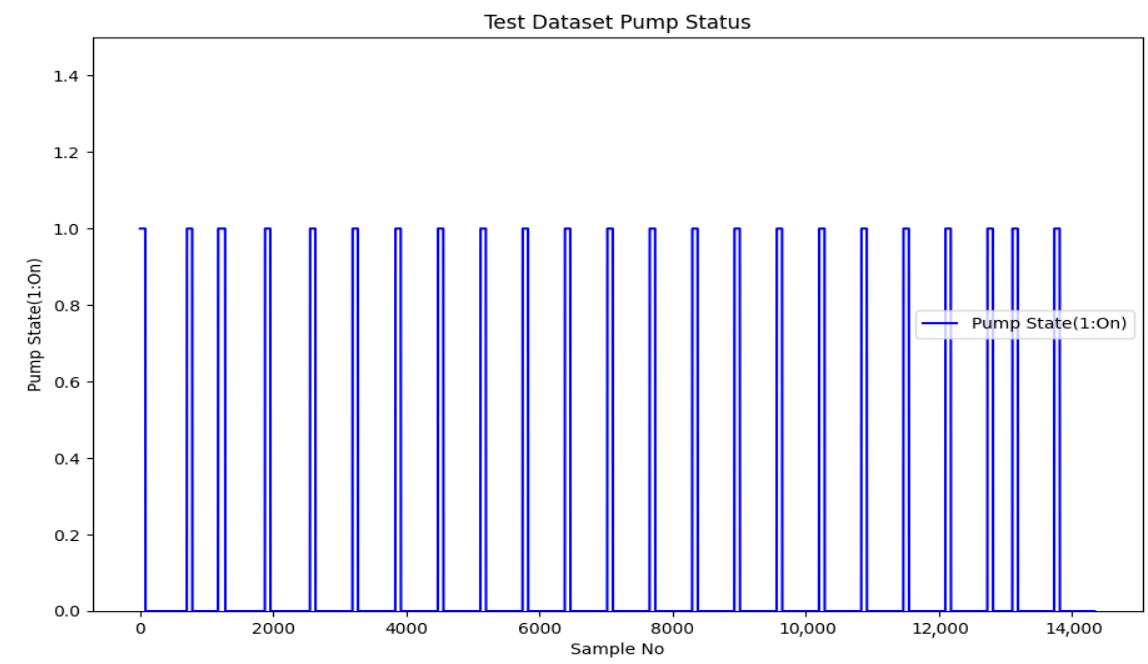
Figure 18. Test dataset pump on/off durations.